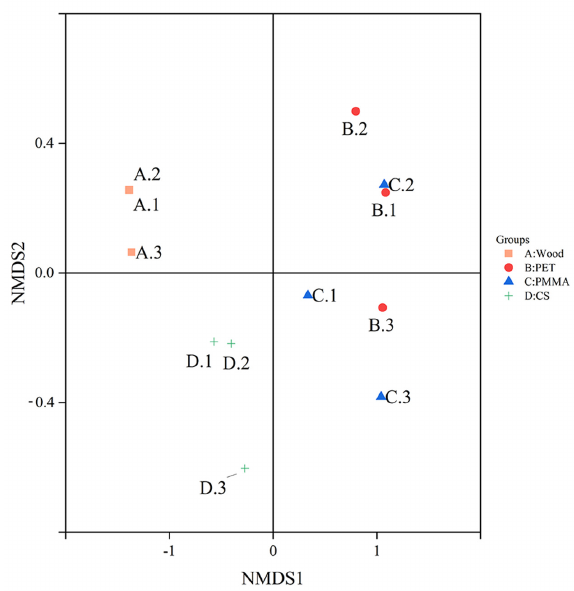
Figure 6. Unweighted nonmetric multidimensional scaling (NMDS) analysis of A (Wood), B (PET), C (PMMA), and D (CS) substrates. On NMDS1 dimension, the A, D and B, C were set apart clearly, which indicates the clear differences of species compositions between the two groups.